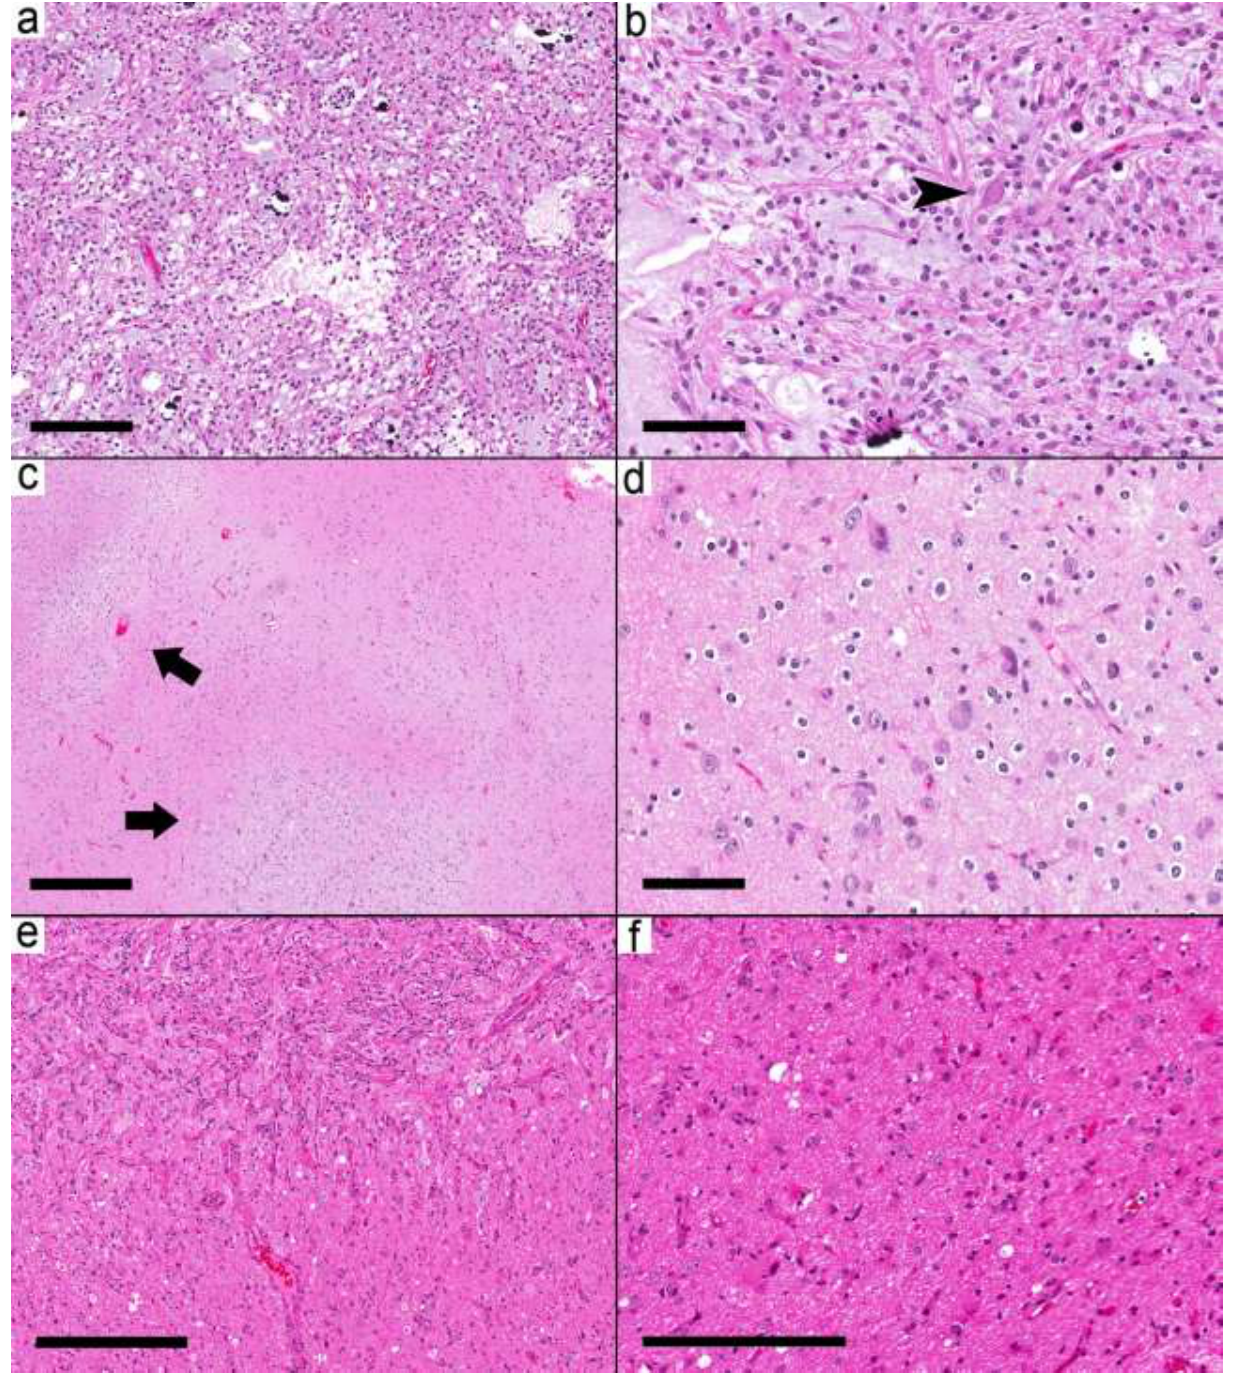
Figure 4. Ganglioglioma with combined circumscribed and infiltrative tumors. ( a ) The relatively demarcated area (Case 19) is formed by microcystic areas and round glial cells. ( b ) Scattered dysmorphic ganglion (arrowhead) in the tumor. ( c – f ) Case 20 shows multiple small nodules (arrows). ( d ) These small nodules are formed by frequent dysmorphic ganglion cells and oligodendrocytes in the background. ( e ) A relatively demarcated cellular area with many dysmorphic ganglion cells in the upper left is separated by less-cellular areas with many dysmorphic ganglion cells from the area in (f). ( f ) The adjacent area shows a mixture of reactive astrocyte-looking cells and a few dysmorphic ganglion cells. Scale bars: 200 µm ( a , f ); 100 µm ( b , d ); 500 µm ( c ); 300 µm ( e ).